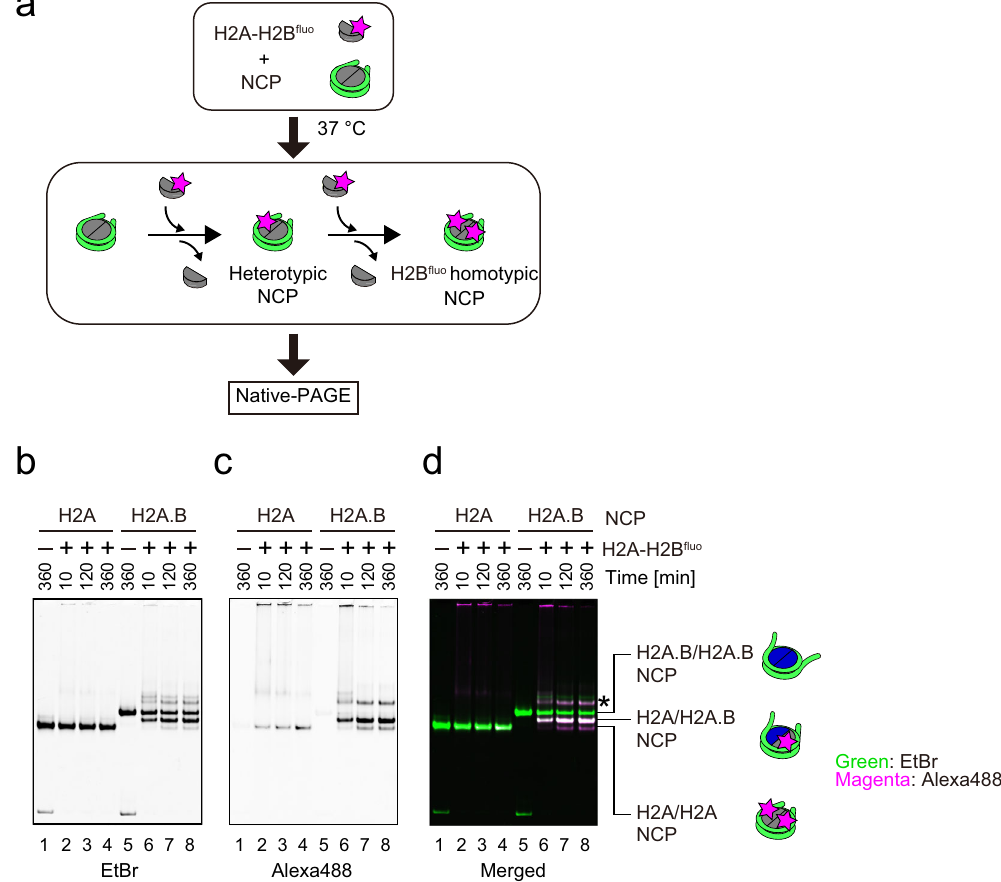
Fig. 2 Histone exchange activity of the H2A.B NCP. a Schematic representation of the histone exchange assay. The NCP was incubated with the H2A-H2B dimer, in which the H2B protein was conjugated with the Alexa Fluor 488 fl uorescent dye (H2A-H2B fl uo dimer). The samples were analyzed by native- PAGE. b – d Representative gel images of the histone exchange assay. The H2A NCP (1 µ M) was incubated with the H2A-H2B fl uo dimer (0 µ M: lane 1; 2 µ M: lanes 2, 3, and 4) for 10 (lane 2), 120 (lane 3), and 360 (lanes 1 and 4) minutes. The H2A.B NCP (1 µ M) was incubated with the H2A-H2B fl uo dimer (0 µ M: lane 5; 2 µ M: lanes 6, 7, and 8) for 10 (lane 6), 120 (lane 7), and 360 (lanes 5 and 8) minutes. After the incubation, the samples were analyzed by native- PAGE. The gels were visualized by ethidium bromide staining, or through the Alexa488 conjugated with the H2A-H2B dimer. b Ethidium bromide; c Alexa488 (H2A-H2B fl uo ); d Overlay of ethidium bromide (green) and Alexa-488 (magenta). The asterisk indicates the NCP-histone complexes. Reproducibility is con fi rmed by three independent experiments, and the results are presented in Supplementary Fig. 3. The uncropped gel images are shown in Supplementary Fig. hypothesis, most of the H2A H2A.B(102 – 114) NCP formed an open conformation similar to that of the H2A.B NCP detected by HS- AFM (Fig. 5b, c, Supplementary Fig. 6, and Supplementary movie S3).